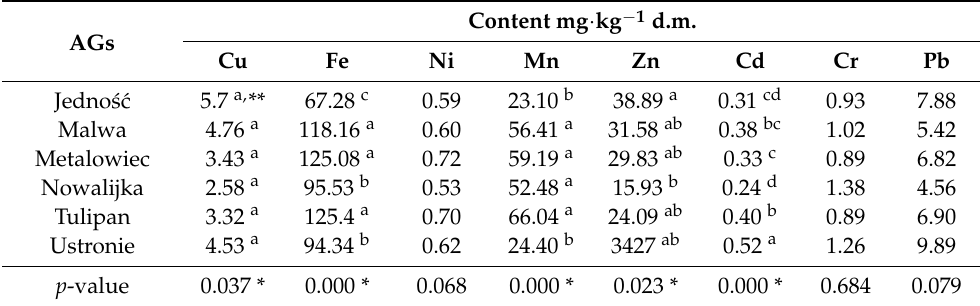
Table 8. The content of heavy metal in soils of six allotment gardens in Gorz ó w Wielkopolski. Content mg · kg − 1 d.m. AGs Cu Fe Ni Mn Zn Cd Cr Pb Jedno´s´c 5.7 a, ** 67.28